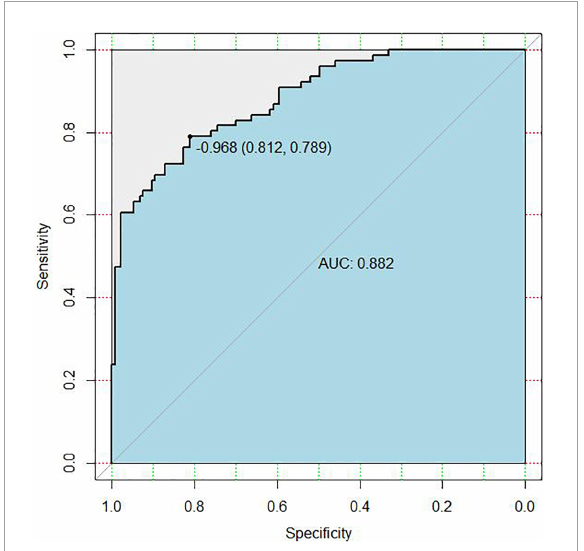
FIGURE3 Receiver operating characteristic (ROC) curve of the nomogram for predicting 6-month unfavorable outcome in elderly cohort with aneurysmal subarachnoid hemorrhage (aSAH) who received endovascular coil embolization. AUC, the area under the curve.